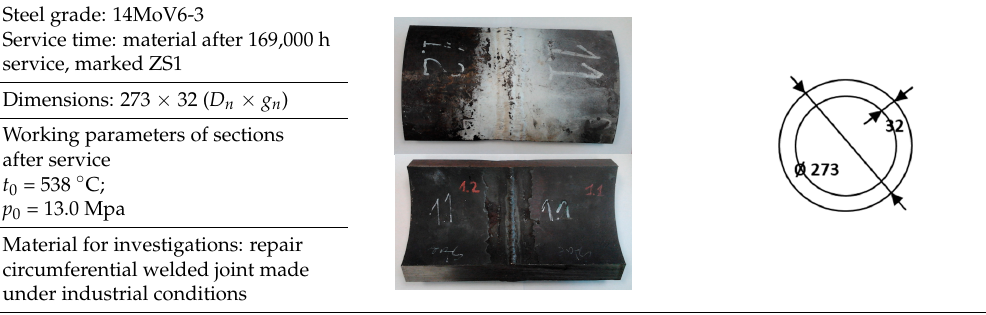
Table 1. Material for investigations.